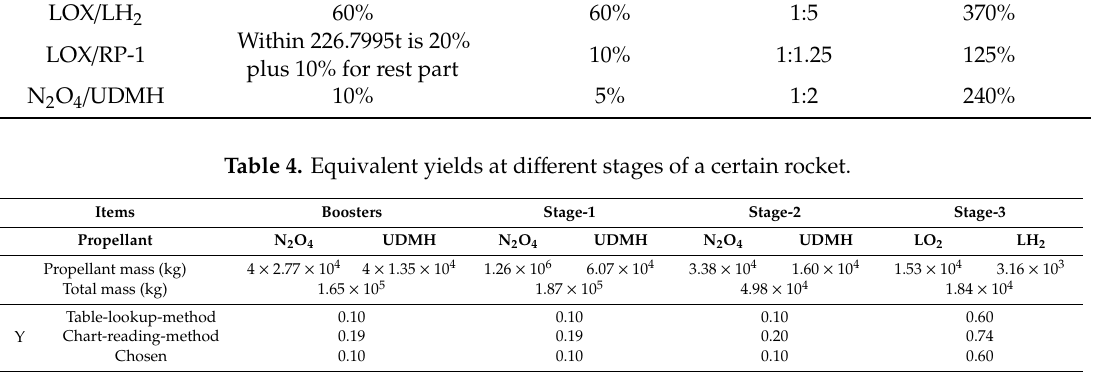
Table 3. Explosive yields and specific coe ffi cients of di ff erent liquid propellant combination under di ff erent explosion modes.